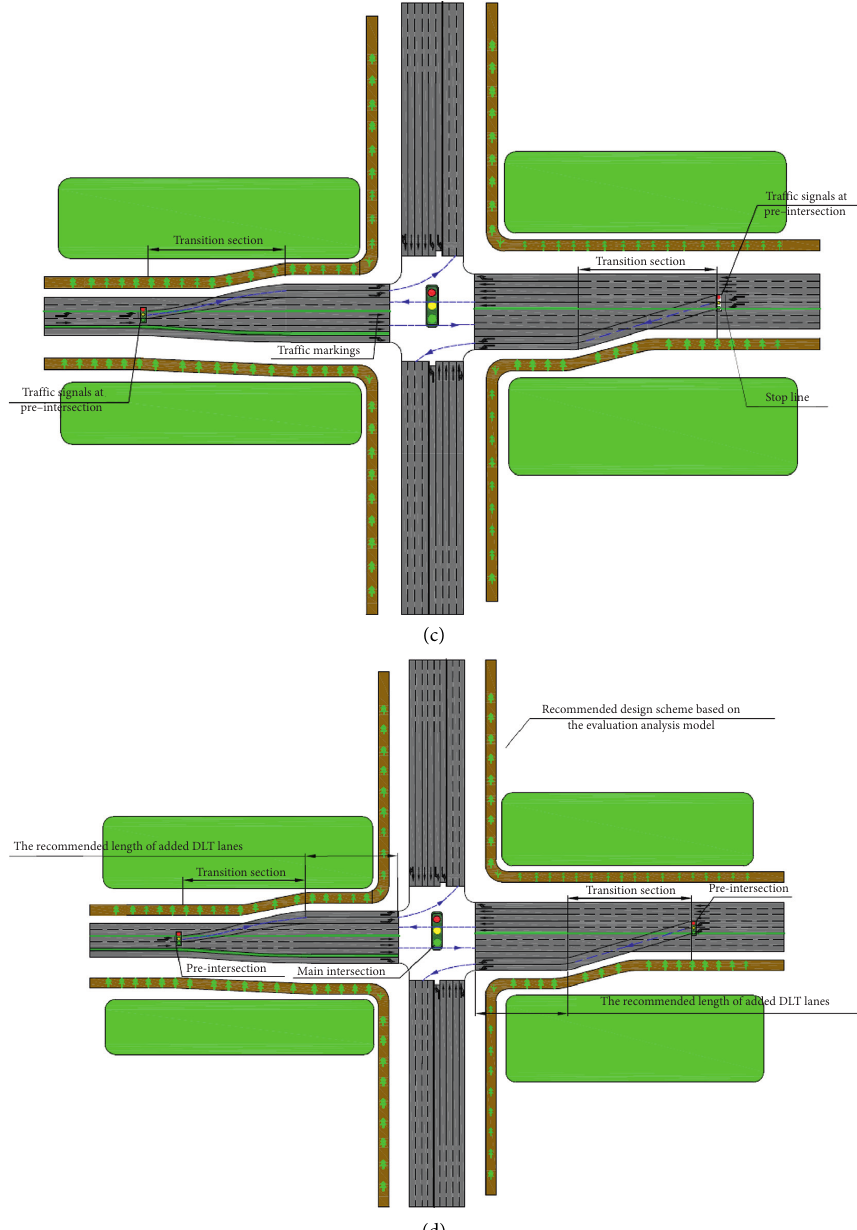
Figure 6: The design method of the DLTscheme. (a) Existing traditional situation. (b) Put forward some possible improvement schemes. (c) Traffic facilities design. (d) Determine the final recommended design